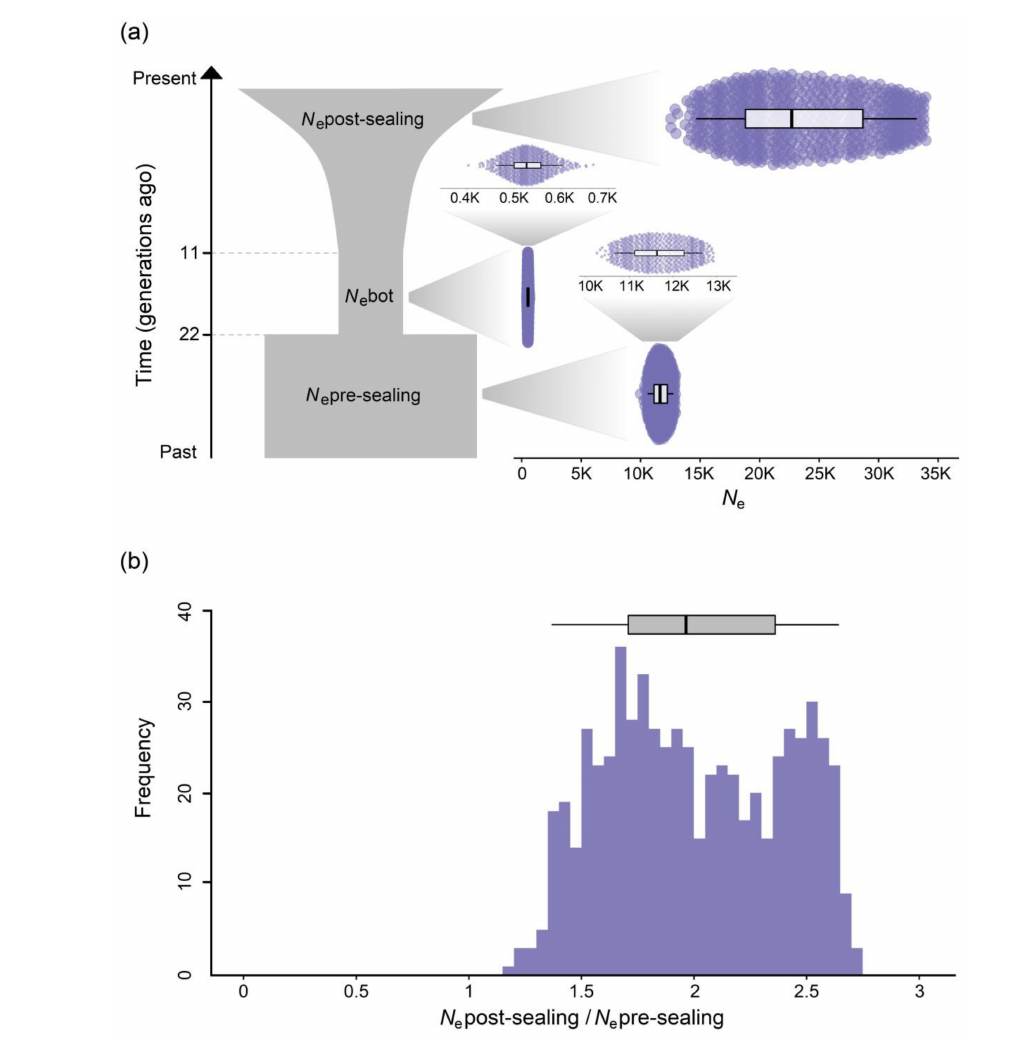
Figure 2. Reconstruction of the recent demographic history of the Antarctic fur seal based on population genomic data. ( a ) Schematic of the best supported demographic model showing the estimated parameter values for N e pre-sealing, N e bot, and N e post-sealing. Dashed grey lines represent the fixed values for the start and end of the bottleneck. The priors for the estimated parameters are described in the Materials and methods. For all three parameters, distributions of 600 non-parametric bootstrap estimates are plotted together with box plots showing median values, and 25th and 75th percentiles, with the whiskers representing 95% confidence intervals. The N e estimates are plotted on the same scale along the x -axis for comparability, while the distributions of N e pre-sealing and N e bot can be seen in the zoom-ins. ( b ) Distribution of the ratio of N e post-sealing to N e pre-sealing over all 600 bootstrapped datasets. The box plot above the bar chart shows the median value, and 25th and 75th percentiles, with the whiskers representing the 95% confidence